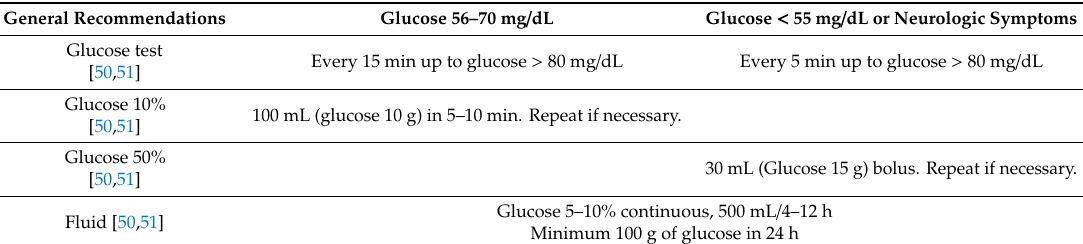
Table 6. Hypoglycemia treatment in patients undergoing